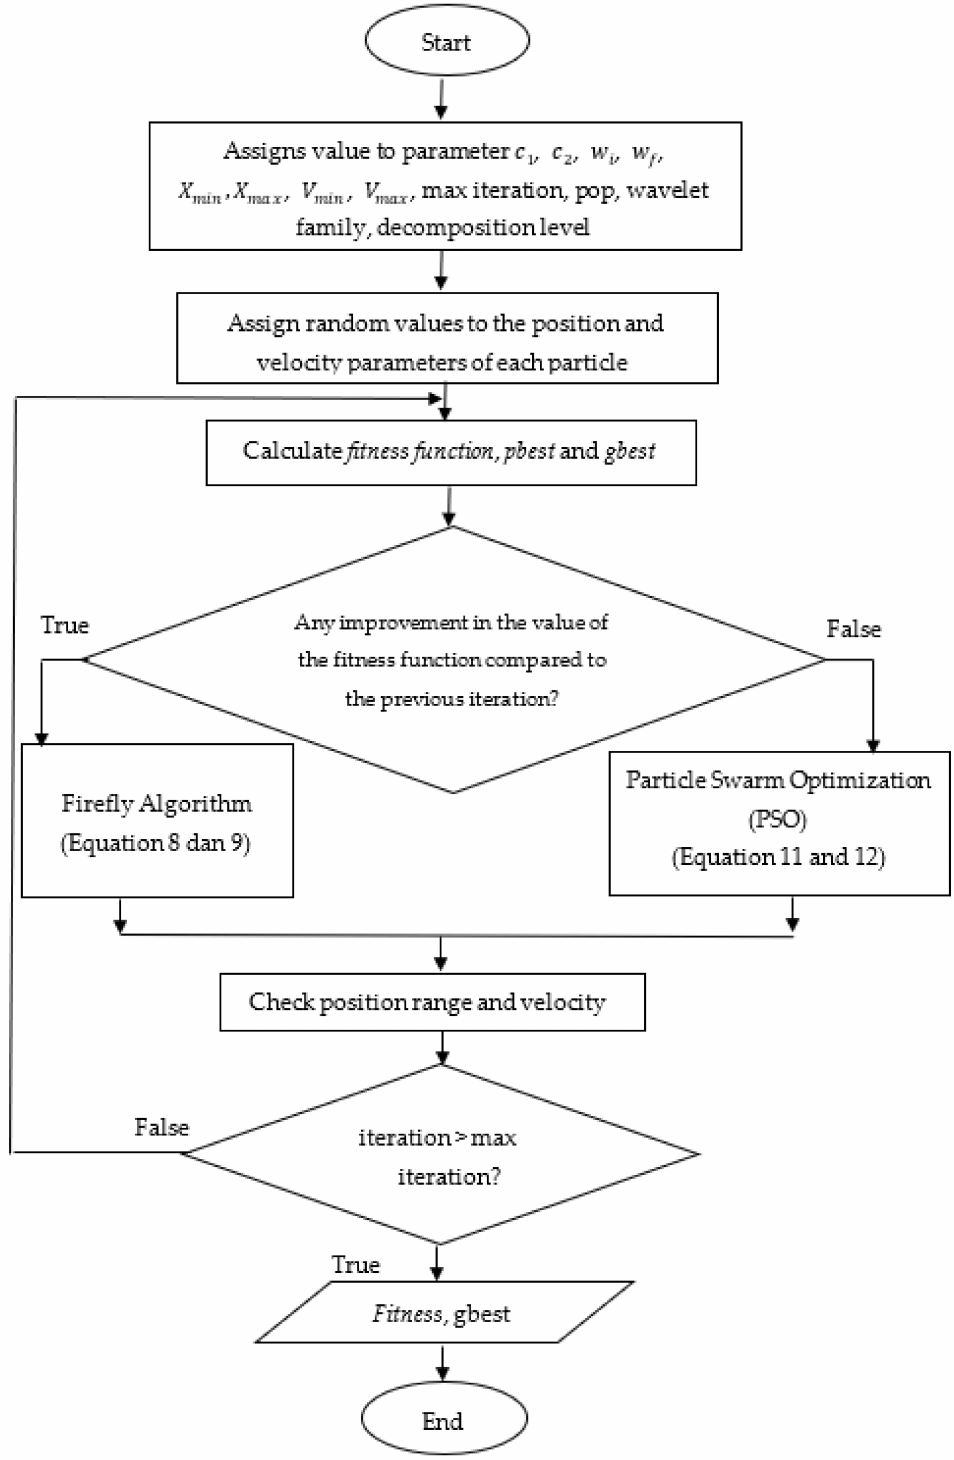
Figure 1. Flowchart of wavelet family and decomposition level optimization using FAPSO